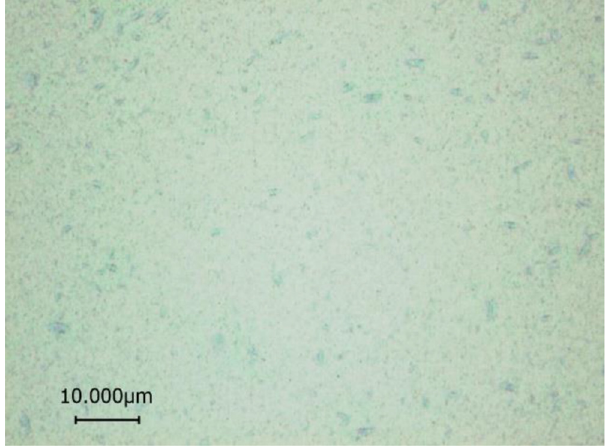
Fig. 4. Ultrasonically spray coated perovskite layer after vacuum quenching and annealing. The perovskite completely covers the glass substrate, being only possible to observe the defects on top of the perovskite